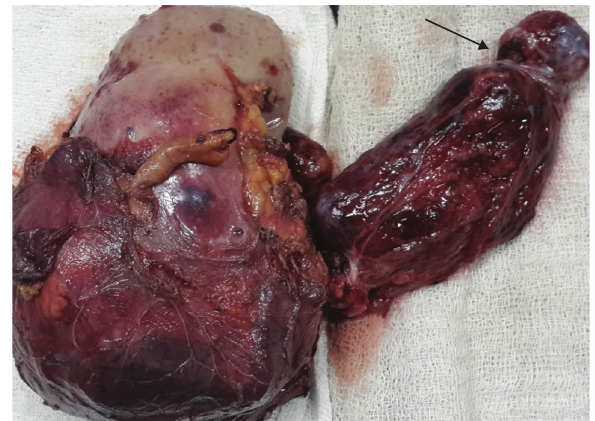
Figure 5: Completion of nephrectomy with tumor thrombus level 4 with arrow showing thrombus removed from atrium and